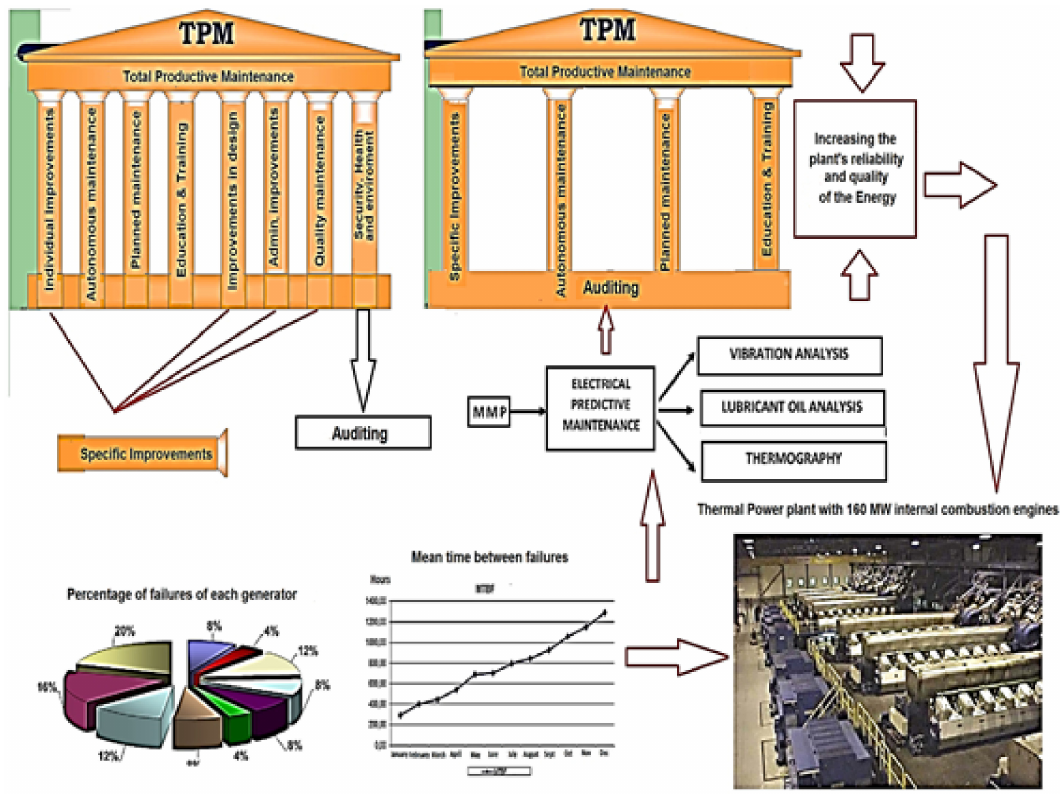
Figure 1. Procedure to ensure the Power plant´ reliability and the energy